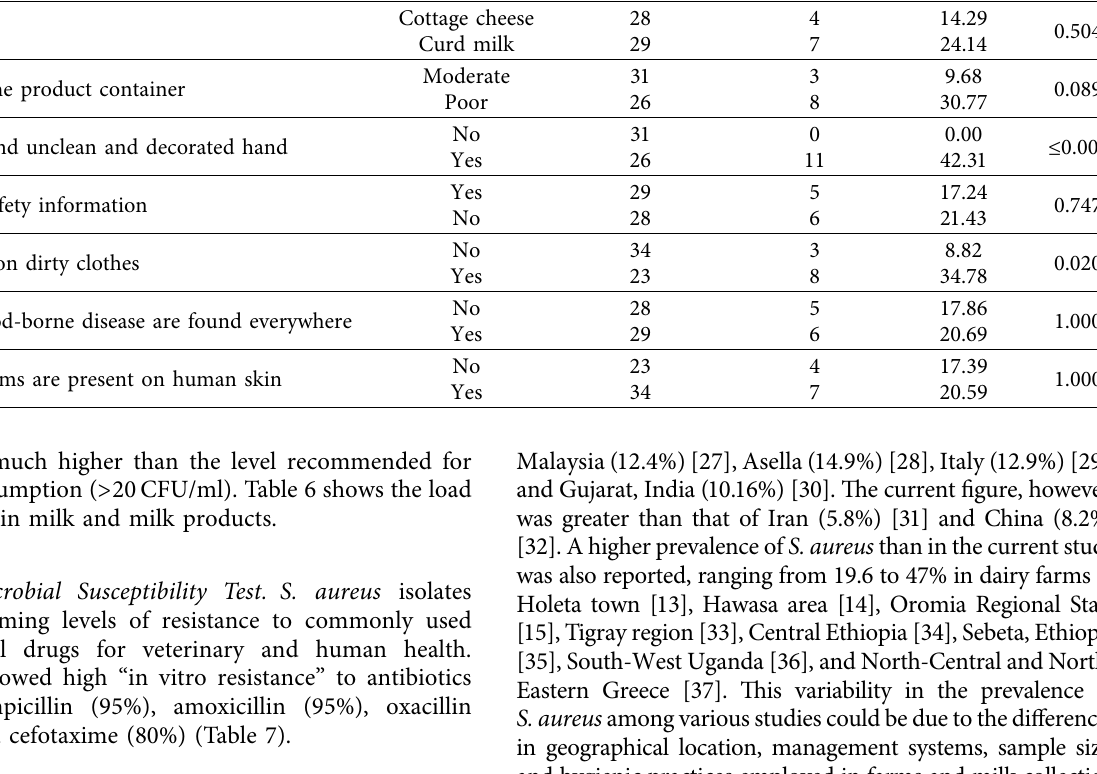
Table 4: Results of the analysis of the association of the prevalence of Staphylococcus aureus in milk products with independent variables.